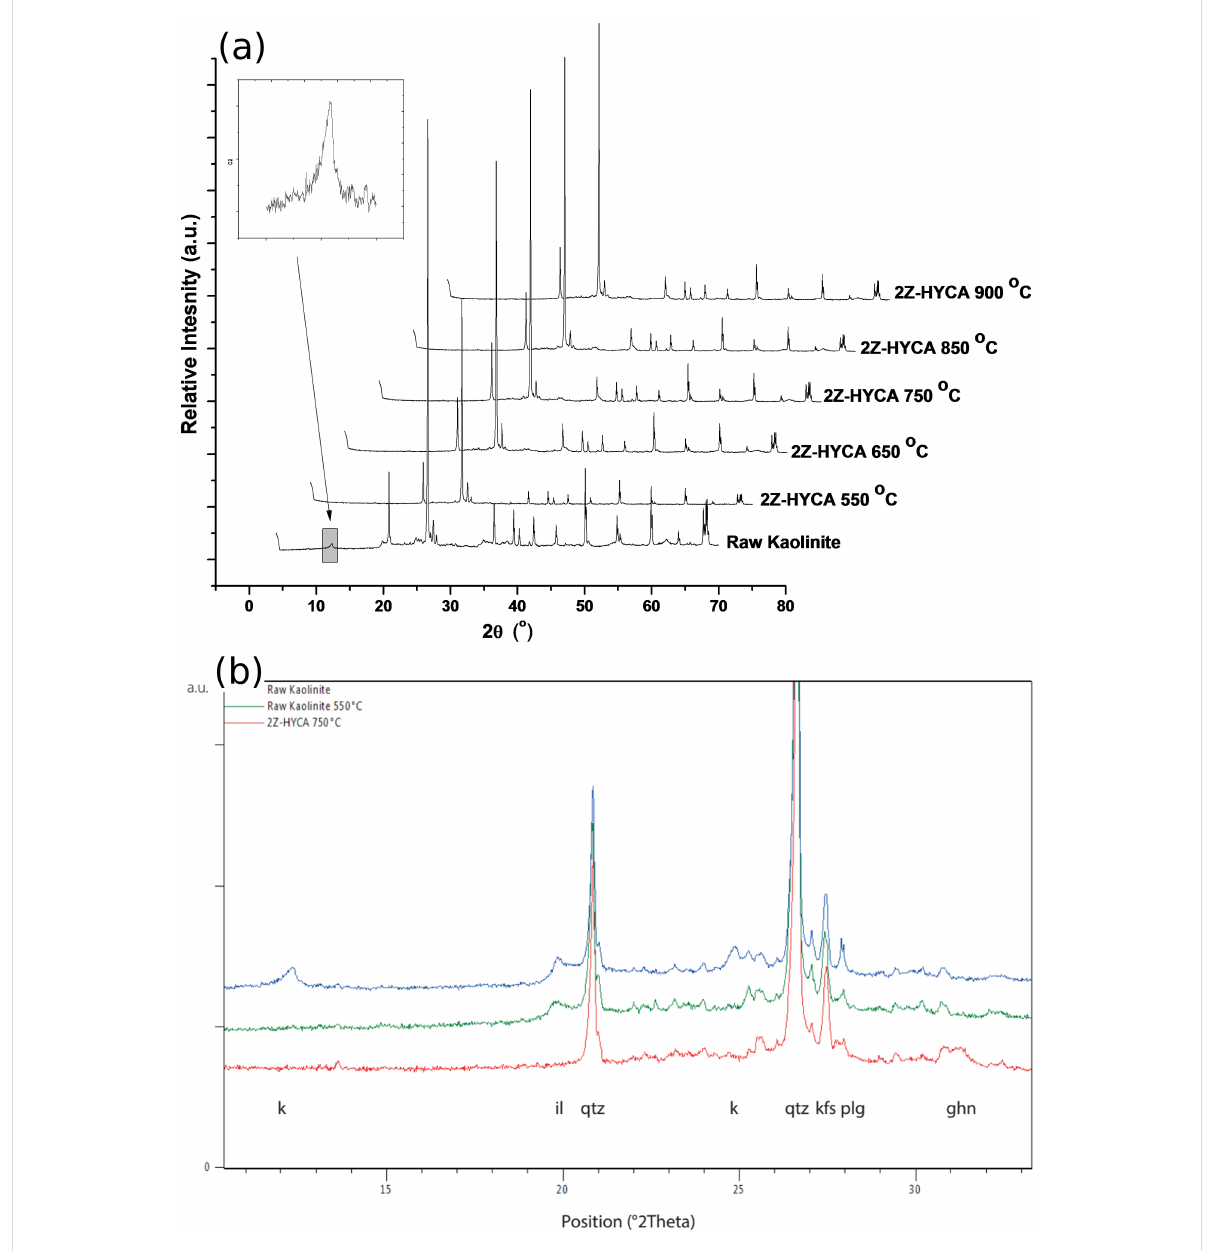
Figure 4: (a) XRD patterns of raw kaolinite clay and 2Z-HYCA composite materials obtained at various temperatures. (b) Powder X-ray diffraction (PXRD) diagrams of raw kaolinite (RK), raw kaolinite heated at 550 °C and 2Z-HYCA prepared at 750 °C. k = K-feldspat (microcline), il = illite, qtz = quartz, plg = plagioclase, ghn =